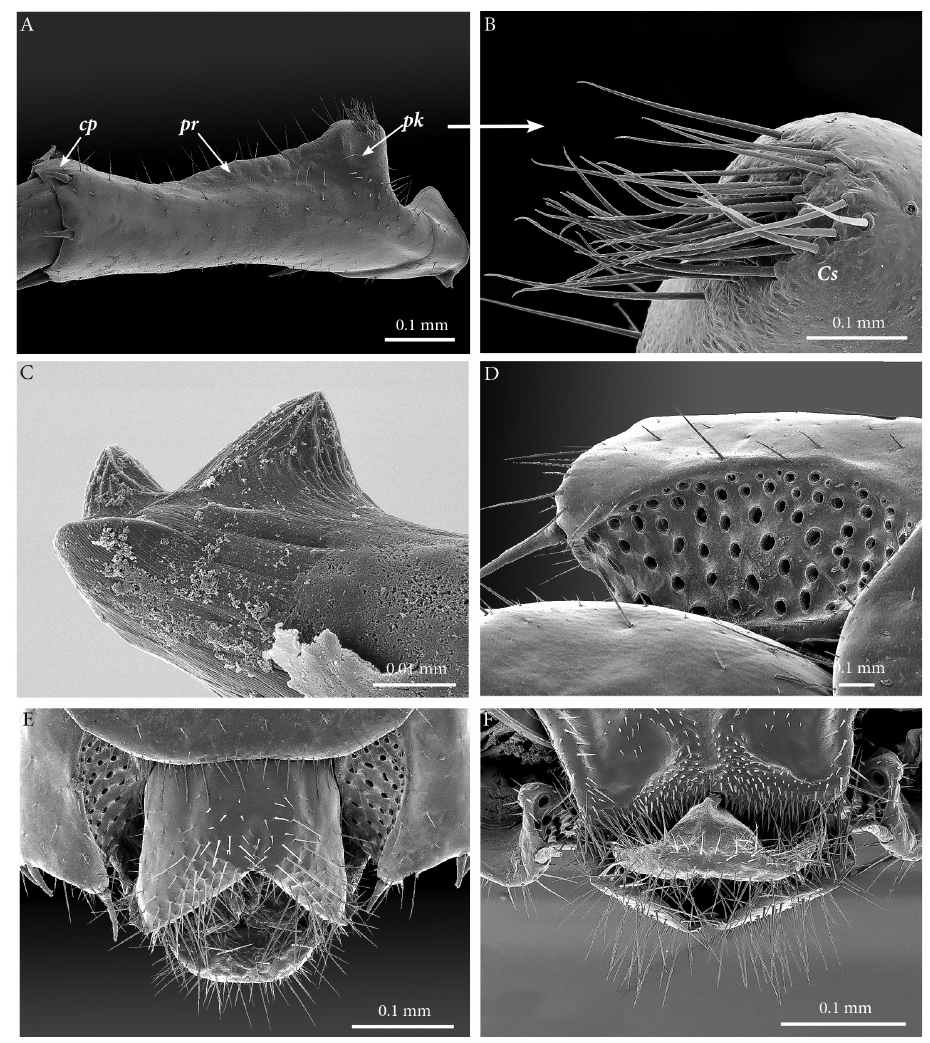
Figure 5. Eupolybothrus liburnicus sp. n., male paratype ZMUC 00040237, leg 15 and genital segment. A Prefemur 15, posteriodorsal view B Close-up of the setae cluster on male prefemur 15 C Close-up of the prefemoral spine D Coxal pore field, ventral view E Genital segment, ventral view F Genital segment, dorso-apical view. Abbreviations: cp : circular protuberance, pk : prefemoral knob, pr : prefemoral ridge, sc : cluster of